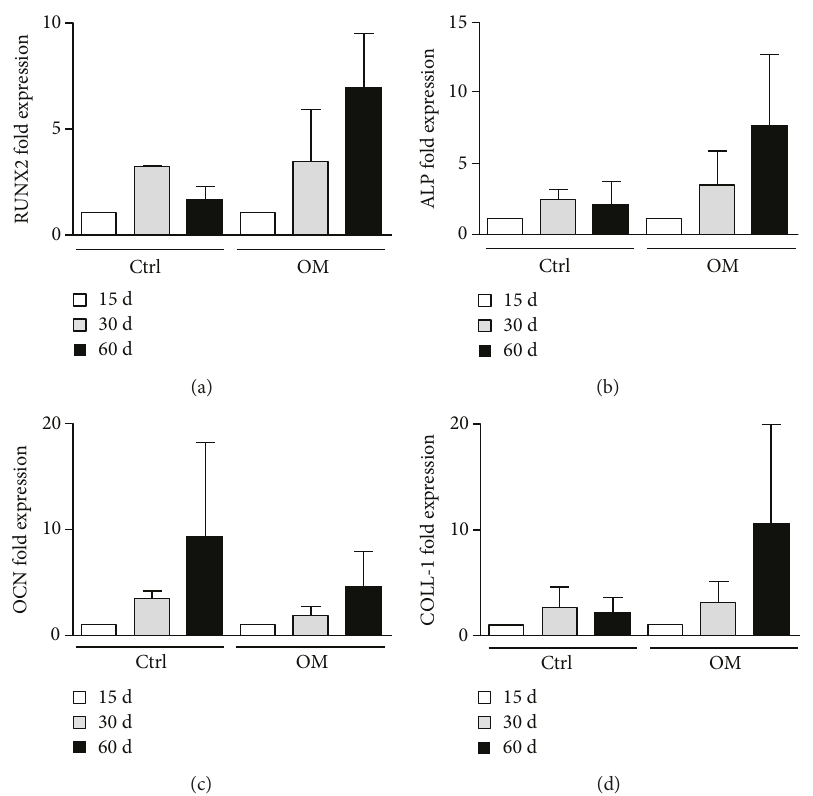
Figure 6: mRNA expression of osteogenic markers in ASCs and SVF plated on SB. The expression of RUNX2 (a), ALP (b), OCN (c), and COLL-1 (d) was analysed on ASCs and SVF plated on SB at 15, 30, and 60 days. A nonstatistically signi fi cant modulation of the expression of these genes was detected both without osteogenic factors (CTRL) and with OM.